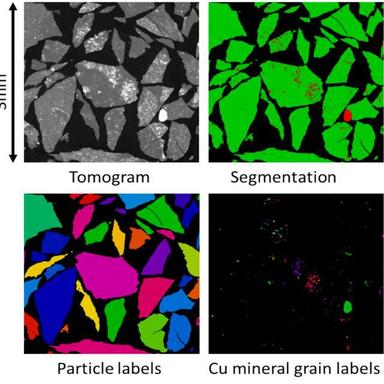
A 2D illustration of some image processing results. In segmentation, black phase is air; green is ore particles; red is Cu mineral grains. In the label images (lower row), each colour stands for an individual object (i.e., particle or Cu mineral grain cluster). Note that due to random colouring of the software, different labels may be shown by similar colours. Only a region from the + 0.25 mm-1 mm image is shown here. (For interpretation of the references to color in this figure legend, the reader is referr